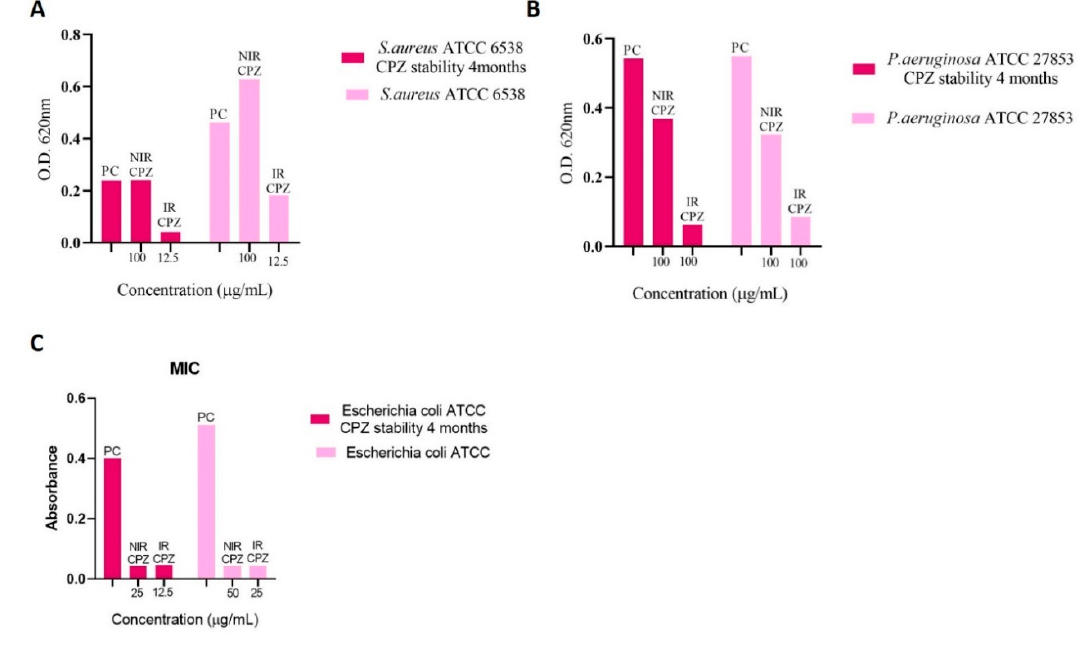
Figure 3. Stability of the antimicrobial activity of the tested compounds after 4 months from preparation of the non-irradiated and laser irradiated solutions. ( A ). S. aureus ATCC 6538, ( B ). P. aeruginosa ATCC 27853. and ( C ). E. coli ATCC 8739 Legend: PC = positive control, NIR-CPZ = non-irradiated CPZ and IR-CPZ = irradiated CPZ.